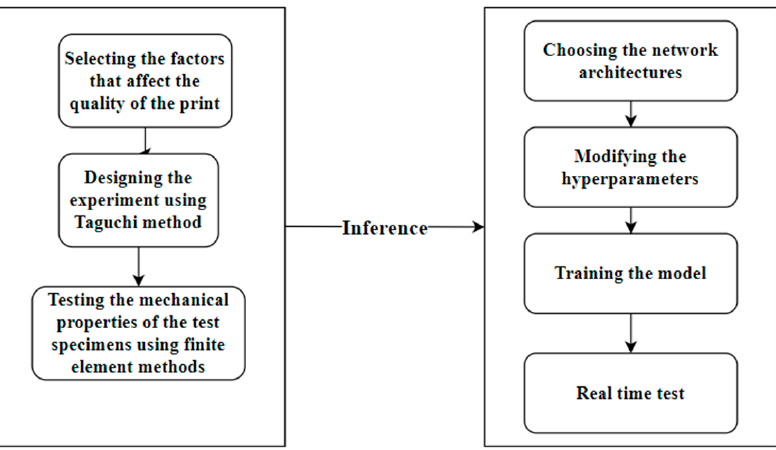
Figure 3. Methodology for training the machine learning algorithm.